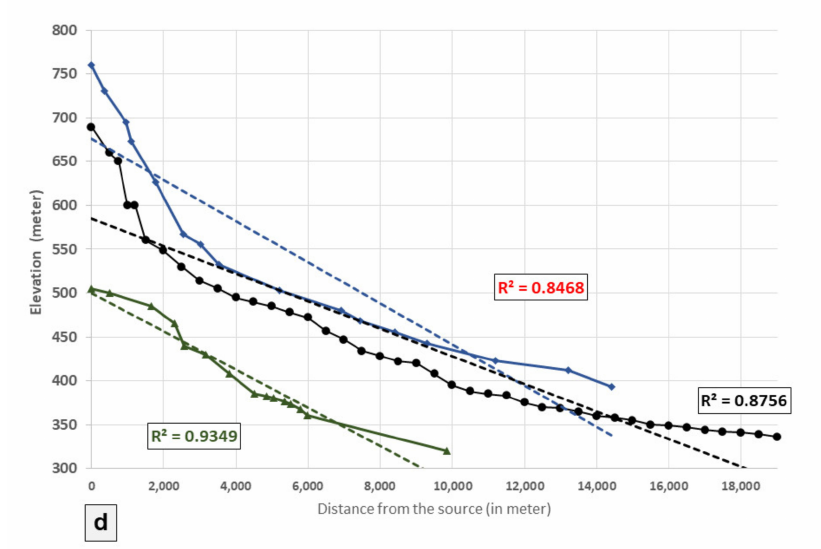
Figure 11. Longitudinal profiles of the SSS reference drainage systems as function of bedrock lithology shown in an x-y plot (elevation vs. distance from the source/watershed in meter). The sinuosity is given in rectangular white boxes. The yellow boxes denote the aerial distribution of mass wasting (normal types) and fluvial deposits (bold types). The inset displays the slope angle as a function of elevation and the subdivision into, CA, TA and DA. The data have been collected during mapping and measurements in the field: ( a ) Rodach River System (VLG-type). The red box gives radiometric age data of the Proto-Rodach, the Sn contents in ppm denote Sn concentration placers along the talweg (90 data); ( b ) Schorgast-Coserbach Drainage System (LHG-type) (42 data); ( c ) Steinach Drainage System (LGG-type). The red boxes give radiometric age data of the Proto-Steinach and the transitional period from the Proto-Steinach into the Pleistocene Steinach. (52 data); ( d ) Fluvial gradients of the VLG-(black line/full dots), LHG-(green line/triangles), and LGG-types (blue line/diamonds) between the top of the upper (peneplain) where the source of the drainage system is situated and the lower (floodplain) planar architectural elements where the river debouches in the foreland. The gradients of the previous longitudinal profiles are determined only for the 1st order drainage systems and numerically expressed as trendlines each of which shown with the correlation coefficients R 2